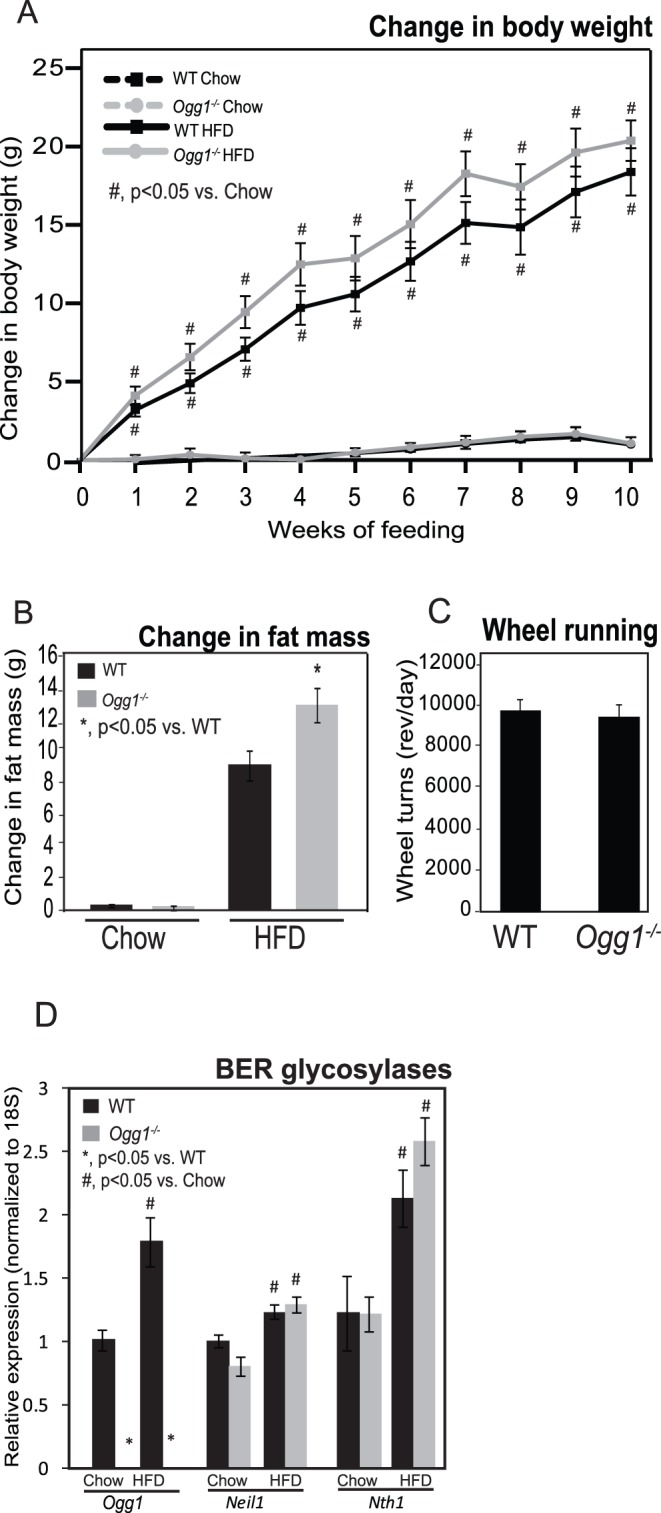
Body weight, body composition, voluntary activity, and gene expression of BER glycosylases.Body weights were measured weekly during the feeding period, and change in body weight from initial body weight was calculated (A). Body composition was measured by NMR at 0 and 4 weeks after the start of feeding, and change in fat mass was calculated (B). Voluntary physical activity was measured by recording wheel running in individually caged, chow-fed mice for 2 weeks (C). Expression of key glycosylases initiating BER of oxidized DNA was measured by qRT-PCR (D). n = 6 for each group; *, p<0.05 vs. WT, #, p<0.05 vs. chow-fed mice.